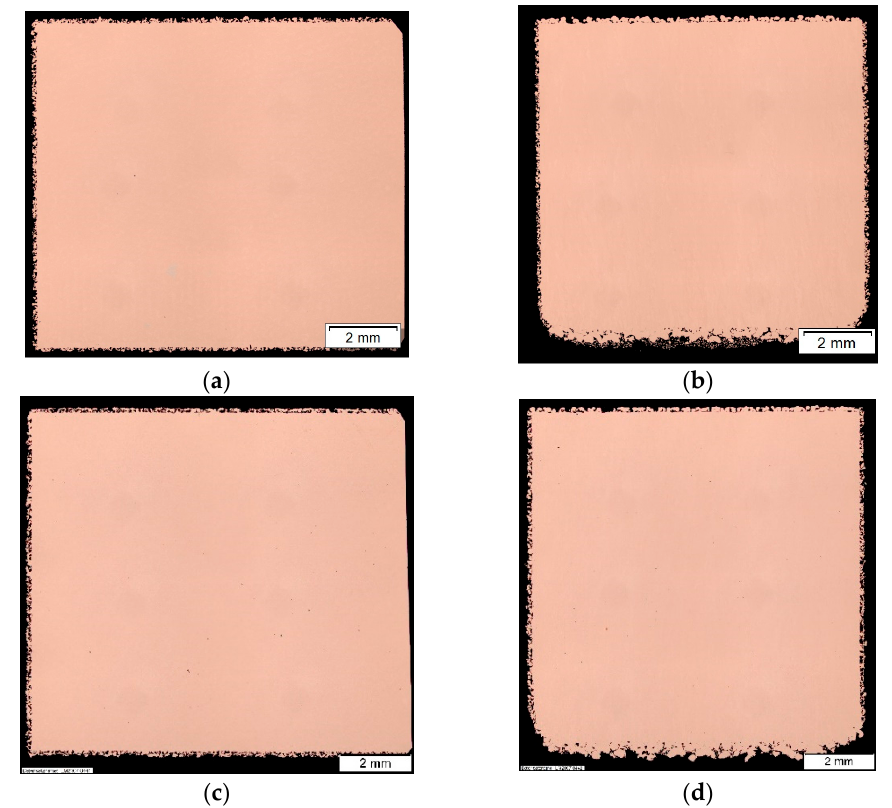
Figure 6. Polished microsection of Cu-OFHC in the ( a ) x-y plane and ( b ) x-z plane and polished microsection of Cu-ETP in the ( c ) x-y plane and ( d ) x-z plane.